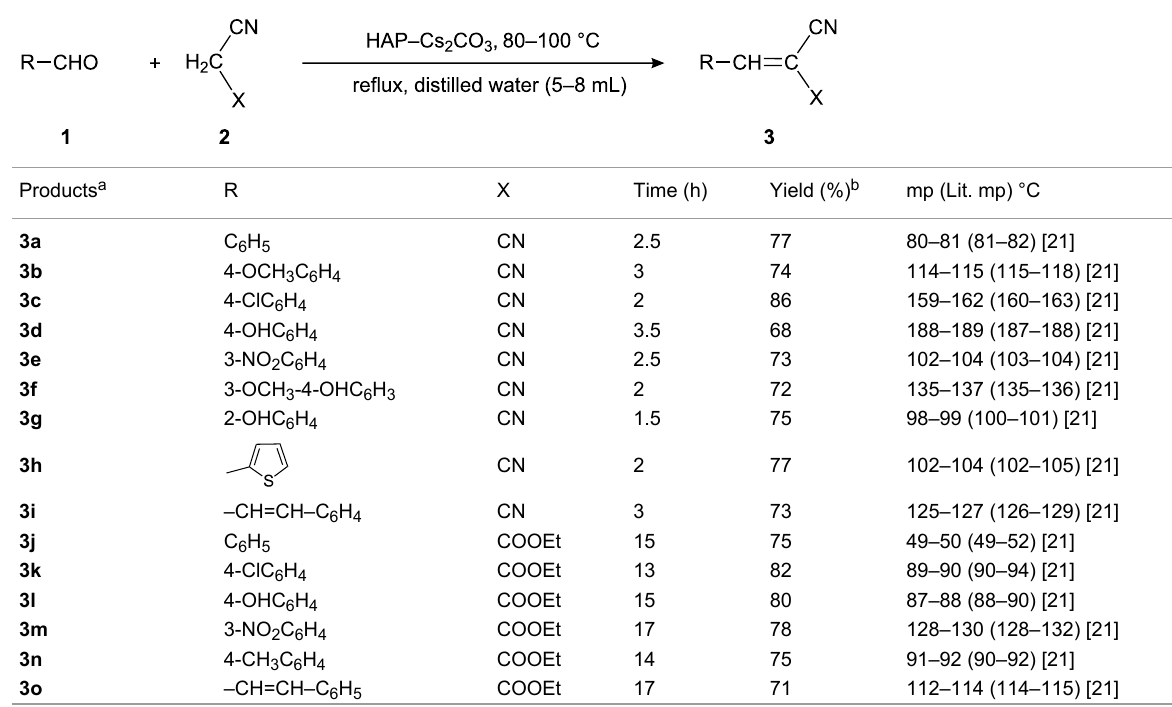
Table 1: HAP–Cs 2 CO 3 catalyzed Knoevenagel condensation between aromatic aldehydes and malononitrile or ethyl cyanoacetate at 80–100 °C with water as solvent.